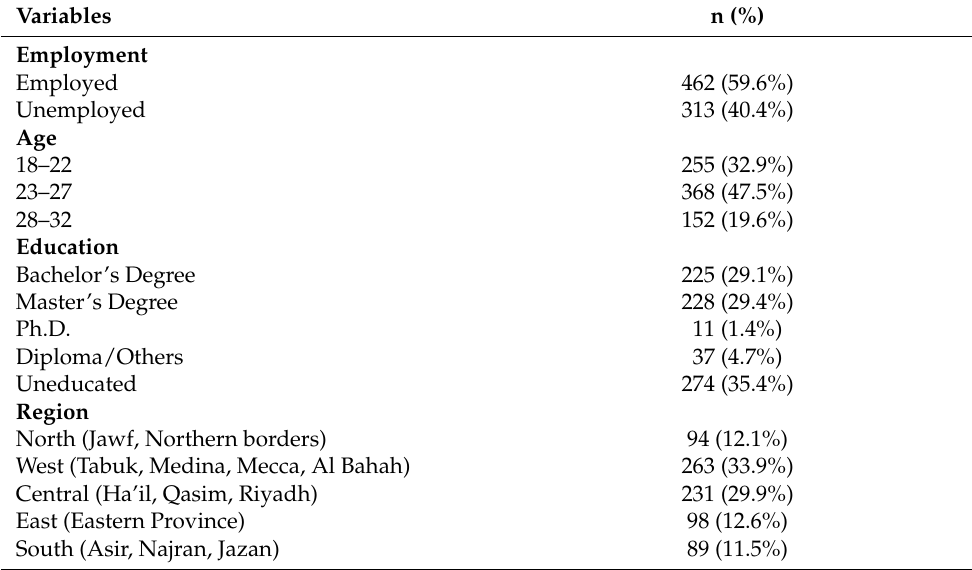
Table 1. Frequency Distribution of Demographic